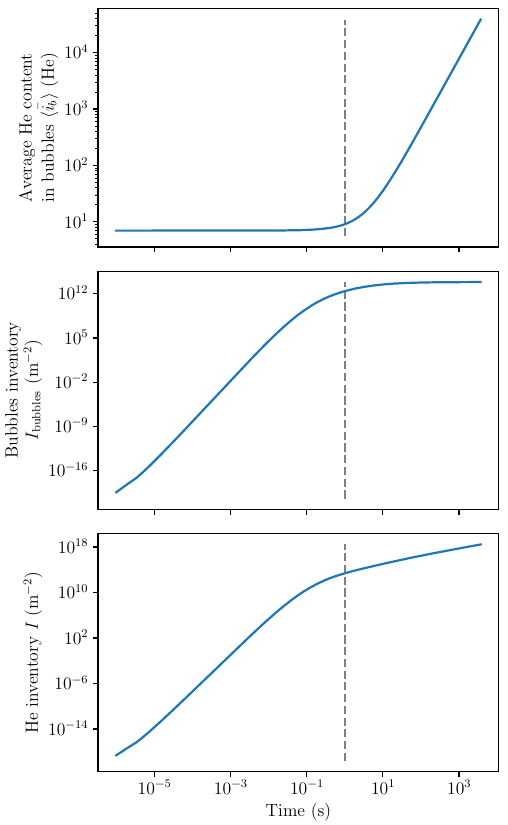
10 18 m − 2 s − 1 and 1020 ×